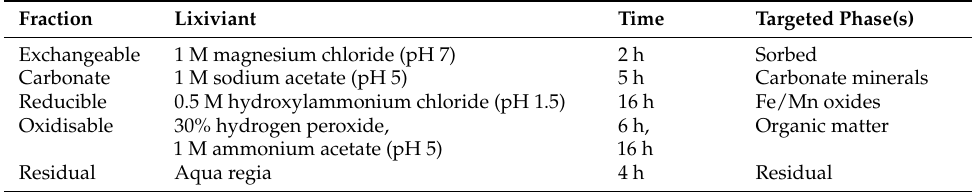
Table 2. Chemical lixiviants used in the sequential extraction and the respective phases targeted per step. The chemicals used in the first three steps were sparged with N 2 prior to use. Fraction Lixiviant Time Targeted Phase(s)